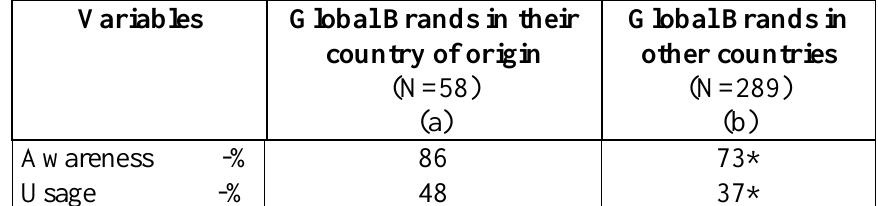
Table 2: Awarness and Usage Levels of Global Brands Variables